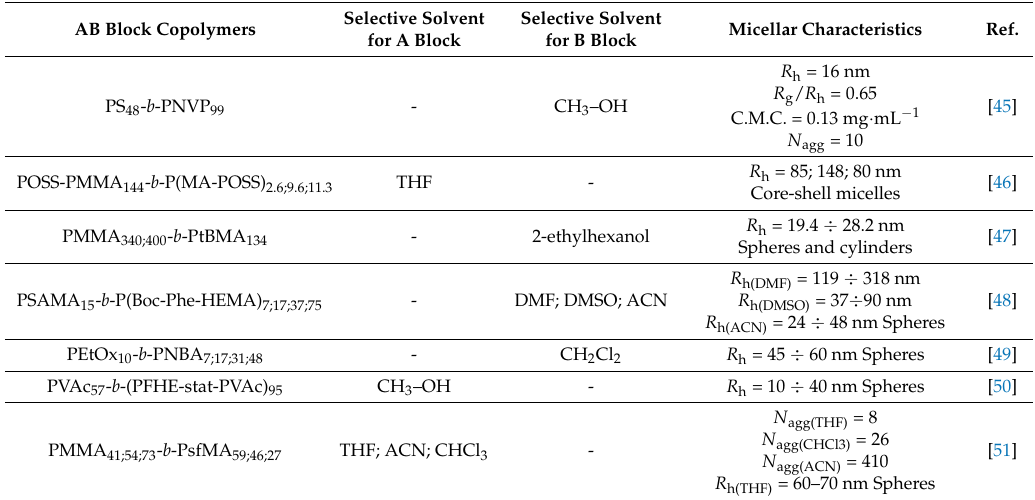
Table 3. Micellization studies of AB block copolymers in pure polar solvents. Selective Solvent Selective Solvent AB Block Copolymers Micellar Characteristics for A Block for B Block